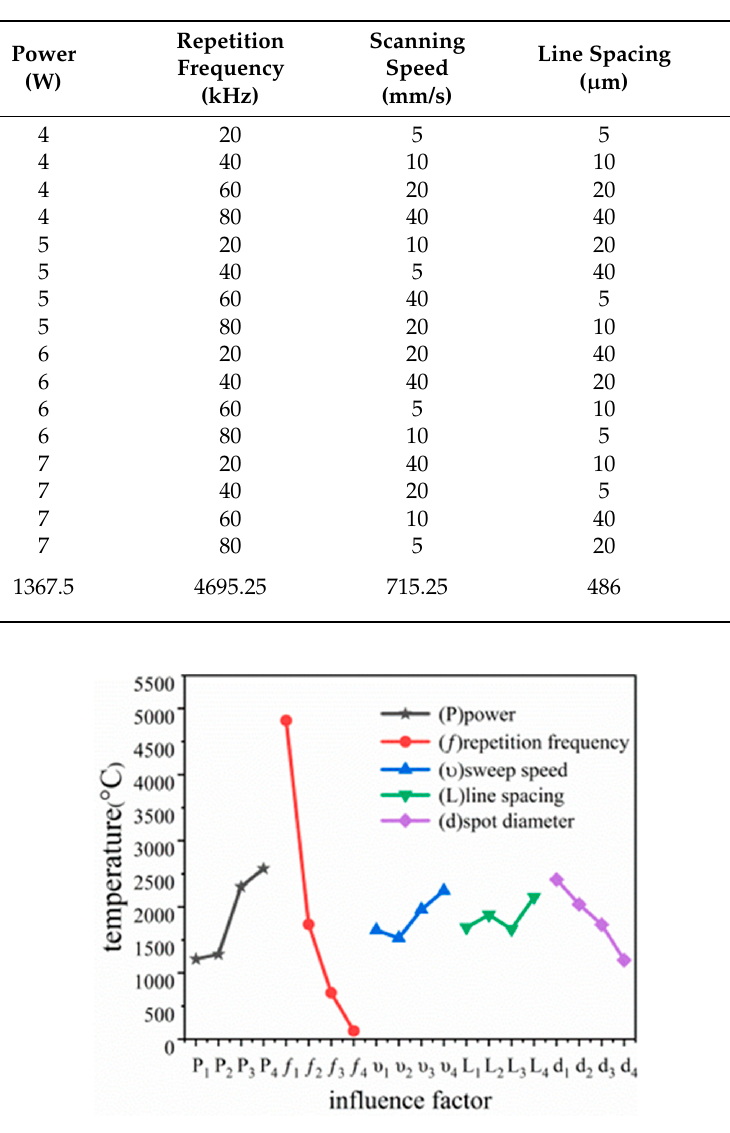
Table 1. Orthogonal experiments for laser processing simulation.